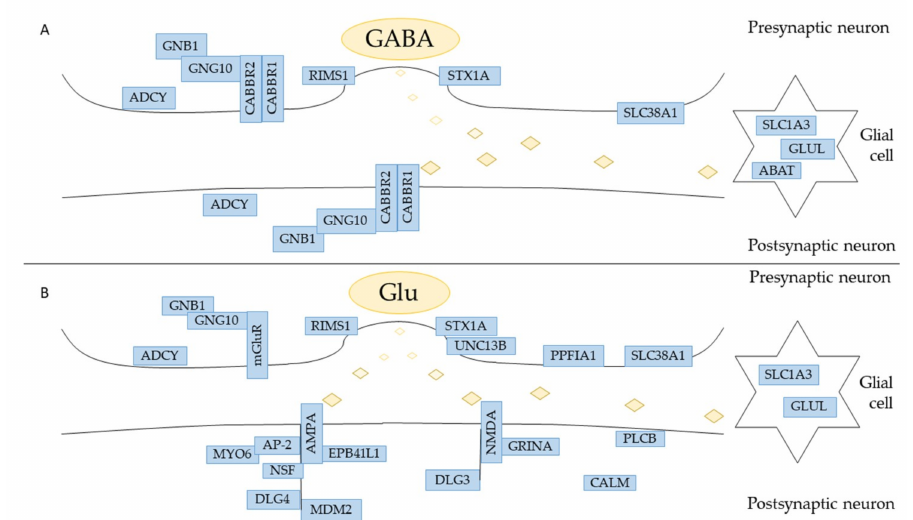
Figure 5. Representation of the synapsis in which are involved GABA ( A ) and glutamate ( B ) neurotransmitter. In the figure, all the genes that were found in hPDLSCs are highlighted. For a better reading, the genes ADCY3 , ADCY4 and ADCY9 are clustered in “ ADCY ”. The genes PLCB1 and PLCB3 are grouped in “ PLCB ”. The genes CALM1 and CALM2 are bundled in “ CALM